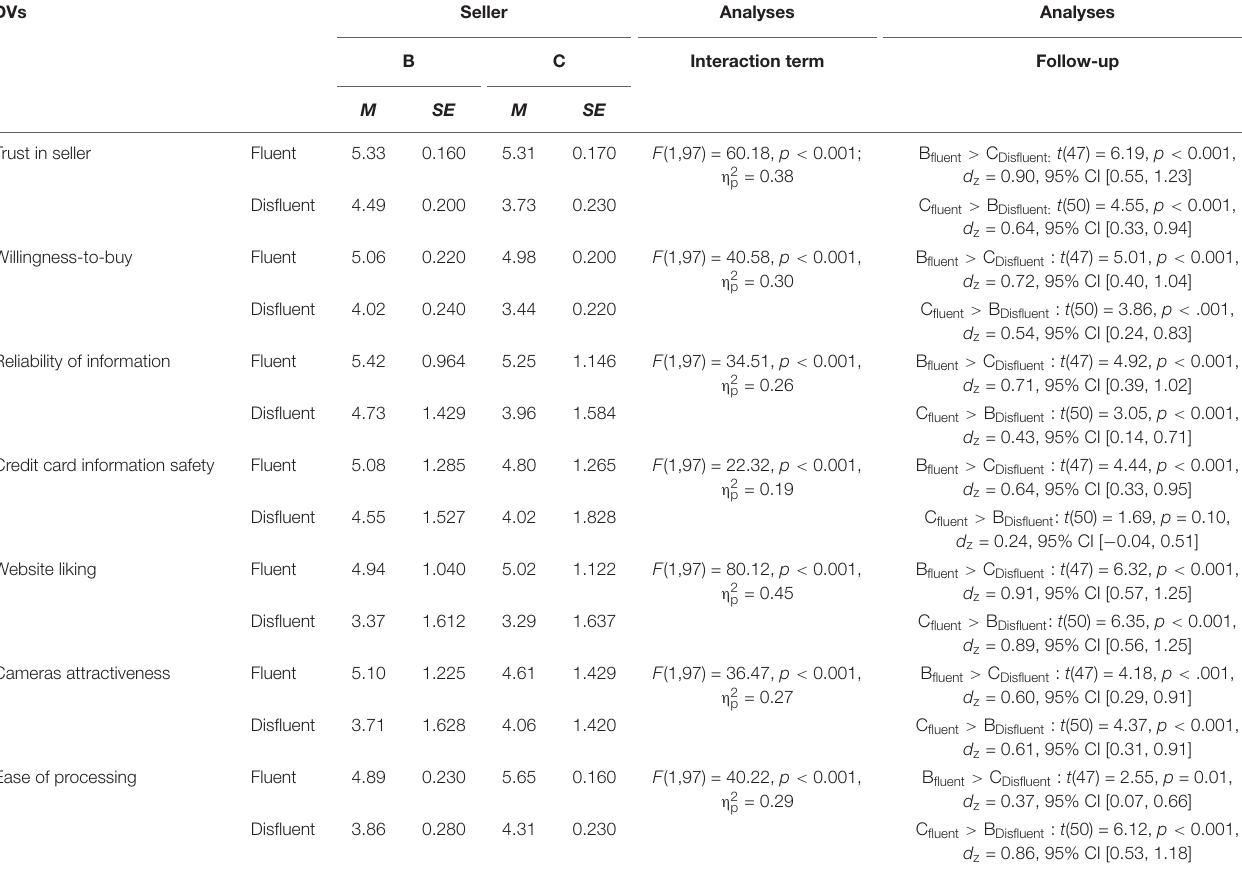
TABLE 1 | Mean ratings for the fluent and disfluent sellers in Experiment 10, interaction terms of the ANOVA and follow-up analyses. DVs Seller Analyses Analyses B C Interaction term Follow-up